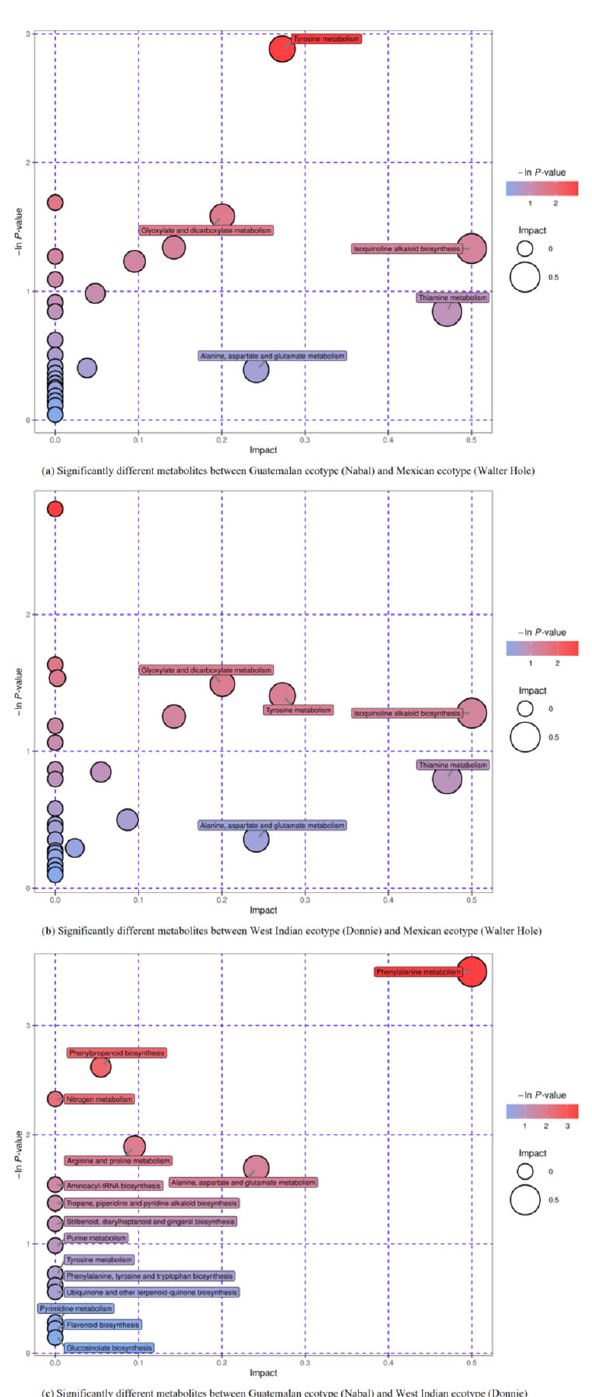
Figure 8. Overview of the analysis of metabolic pathways among the mature avocado mesocarps of three ecotypes. The y -axis ( − ln ( p -value)) indicates the significance of the metabolic pathway enrichment. The x -axis indicates the impact of the pathway as determined by the Pathway Topology Analysis.